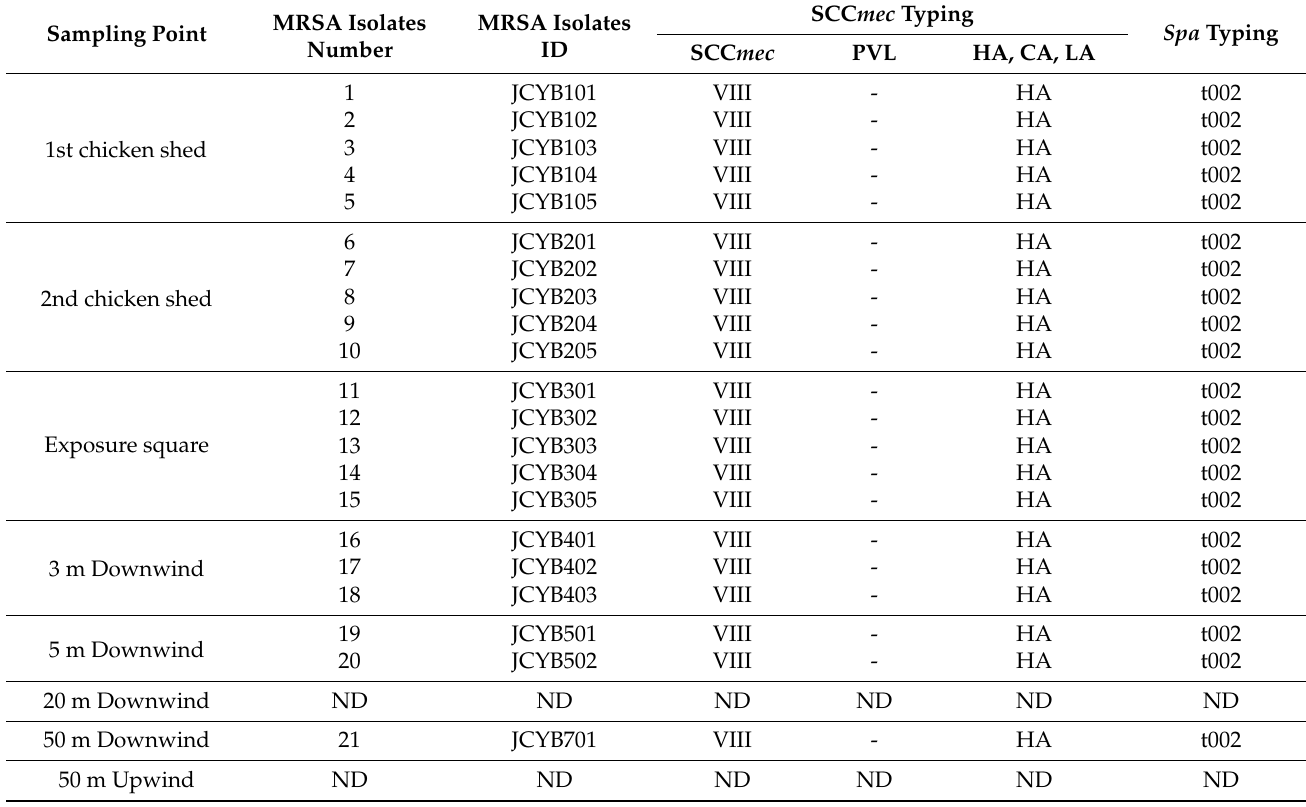
Table S5. Table 2. SCC mec and spa typing outcome of MRSA isolates.